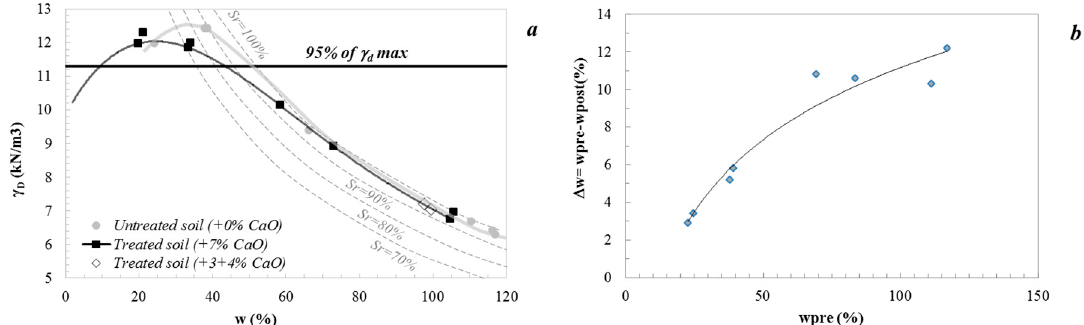
Figure 3. Compaction curves (standard effort) of ( a ) the treated and untreated soil (Sr = degree of saturation) and ( b ) water content reduction for treated compacted samples.